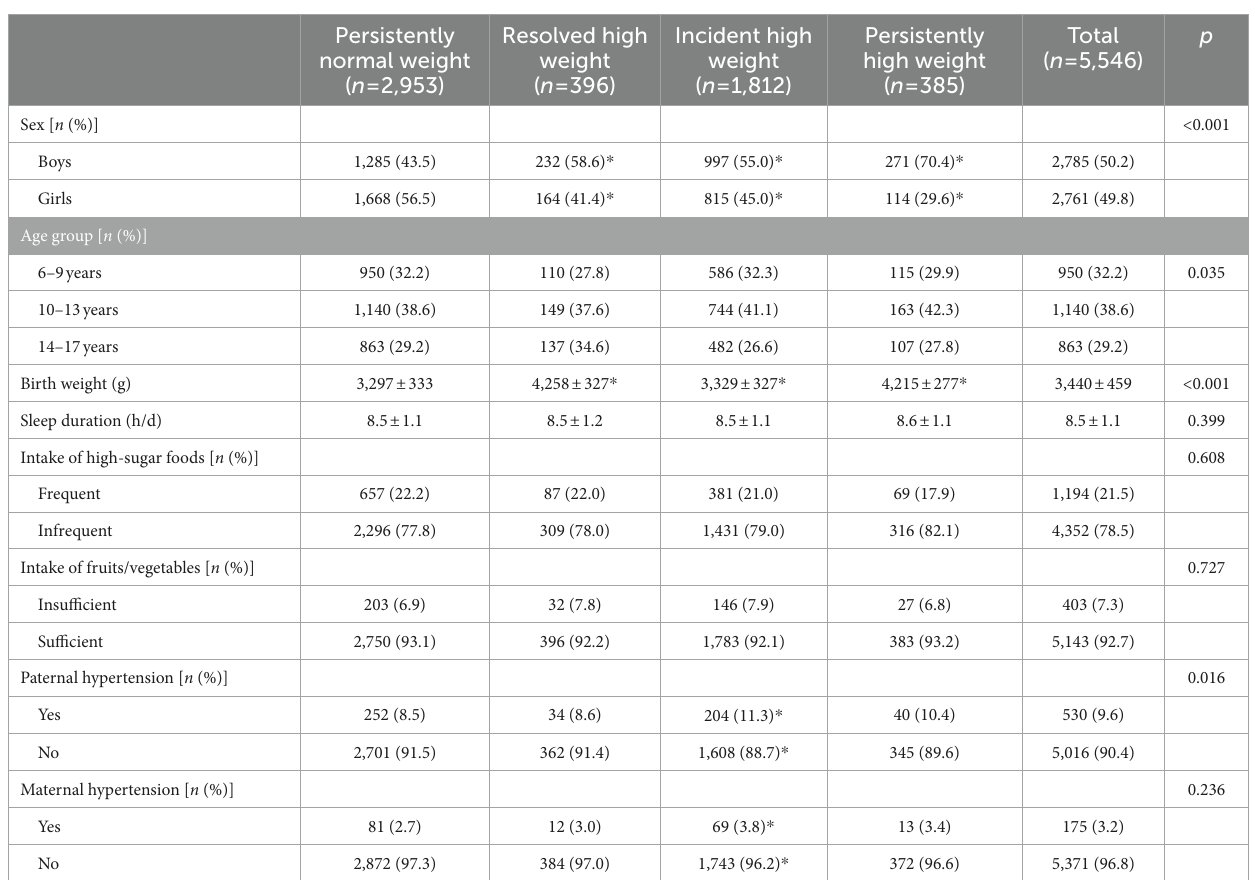
TABLE 1 Basic characteristic of participants across the weight status change groups.